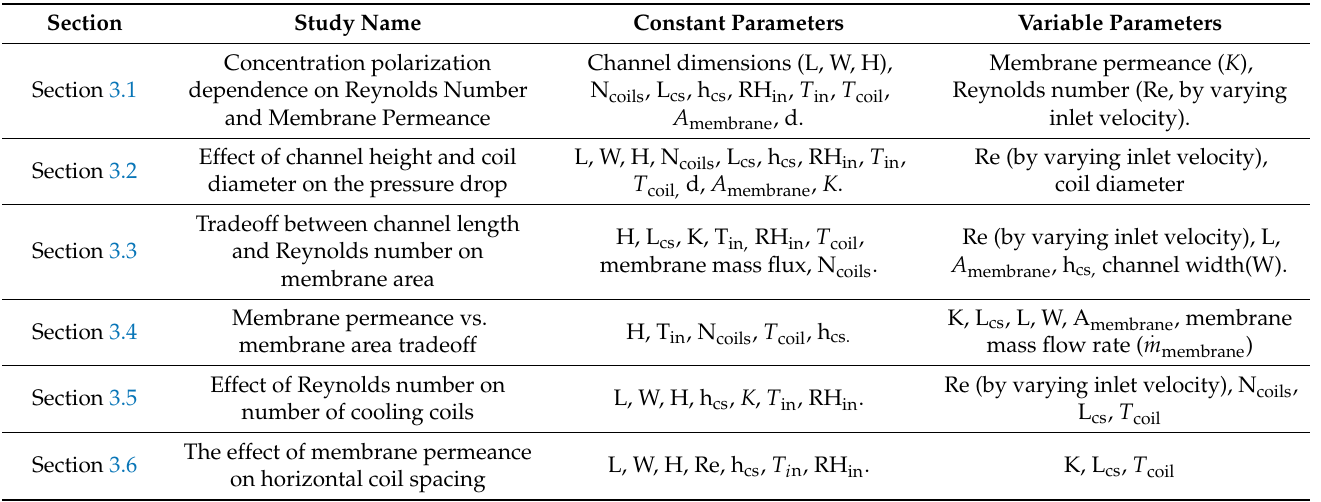
Table 1. Summary of test results from CFD with constant and variable parameters used for obtaining each